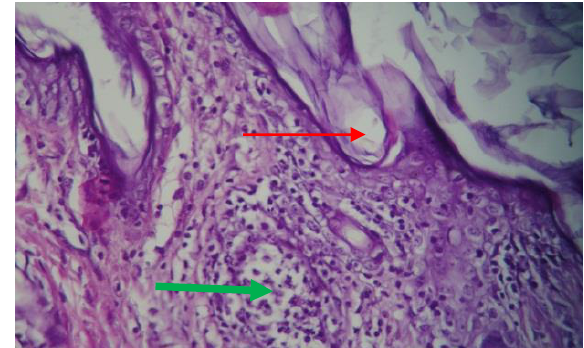
Fig,2: Section in the skin of infected non- immunized animal at day 5 post challenge showed neutrophil infiltrate around hair follicle in the dermis with keratin debris seen in the follicular opening (H&E stain 400X).